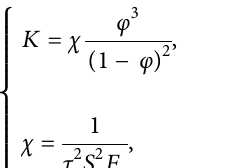
Table 1: Values of the nonequilibrium decomposition model of calcium compounds [25]. Skeleton compound